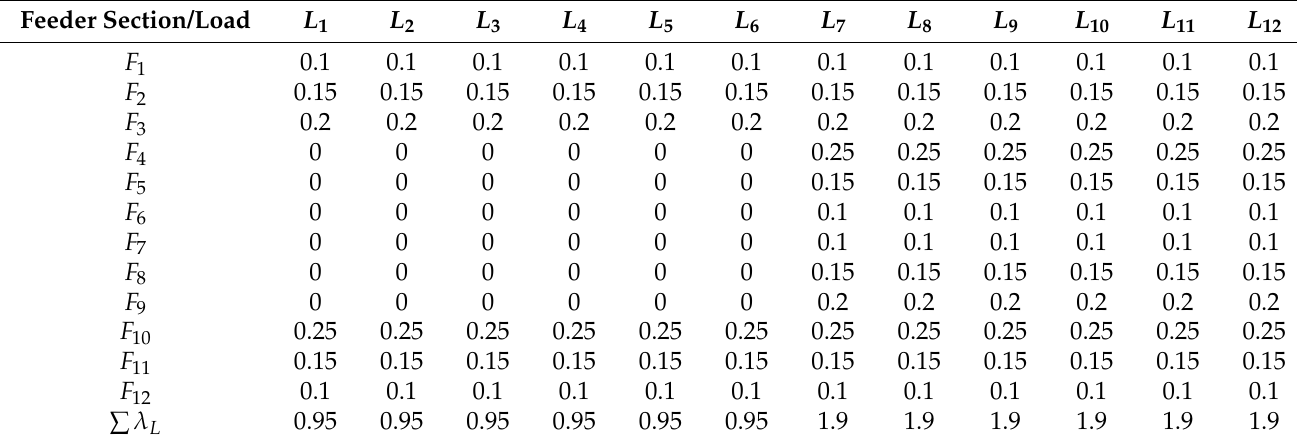
Table 4. Failure rate of various feeder sections after placement of a recloser in feeder section F 4 .